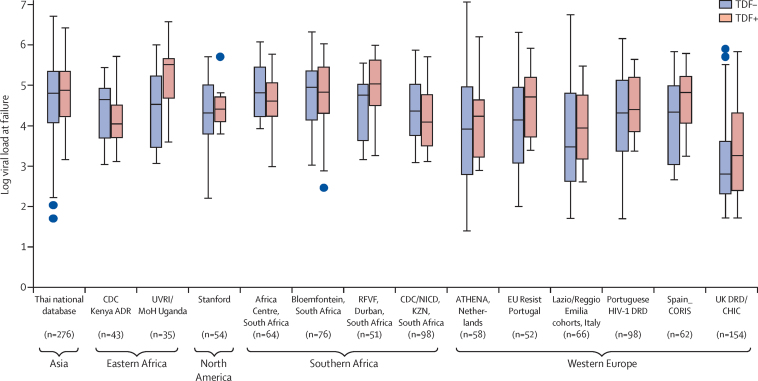
Boxplot of log viral load by presence (TDF-positive) or absence (TDF-negative) of tenofovir resistance at viral failure in studies with at least ten patients with TDF resistance and a viral load measurement at treatment failureWe restricted to studies with at least ten TDF-resistant mutations to help with graphical clarity, although the pattern of similar distributions of failure viral load in the presence or absence of TDF resistance was true for all studies. TDF=tenofovir disoproxil fumarate. Blue dots represent outliers.